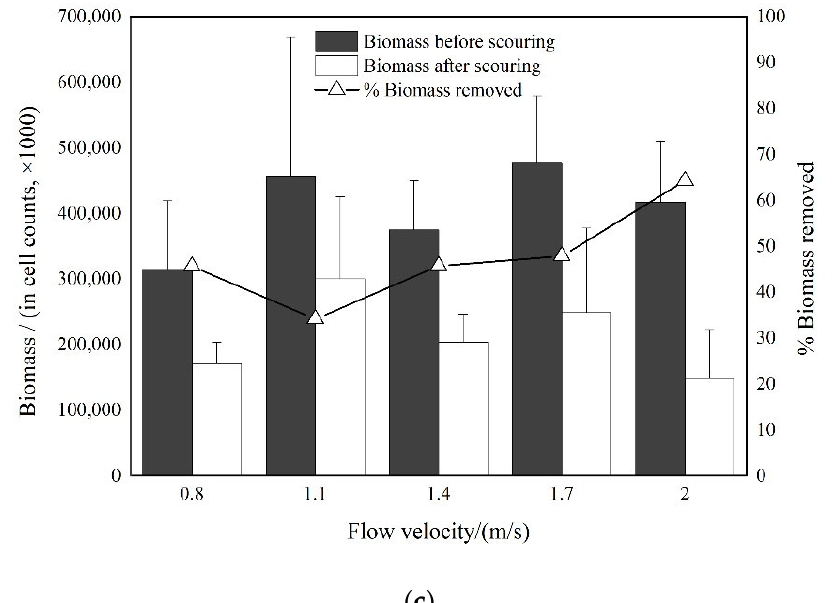
Figure 6. Variation of the biomass of benthic algae (in cell counts, mean + SD) before and after scouring by different flow velocities, 0.8, 1.1, 1.4, 1.7, and 2.0 m/s. ( a ) Variation of the biomass of green algae. ( b ) Variation of the biomass of blue–green algae. ( c ) Variation of the biomass of diatoms. The removed proportions of green algae and diatoms were significantly higher than that of blue–green algae. Through the one-way ANOVA to analyze the different impacts by taxa on removal percentages, the results showed that the impacts of green algae, blue– green algae and diatoms on the means of removal percentages are significantly different ( p = 4.77 × 10 − 7 < 0.01). According to the pairwise comparison by Fisher test, the different ( p = 1.96 × 10 − 7 < 0.01), and also significant in the different impacts between diatoms and blue–green algae ( p = 2.77 × 10 − 5 < 0.01), but not significant between diatoms and green